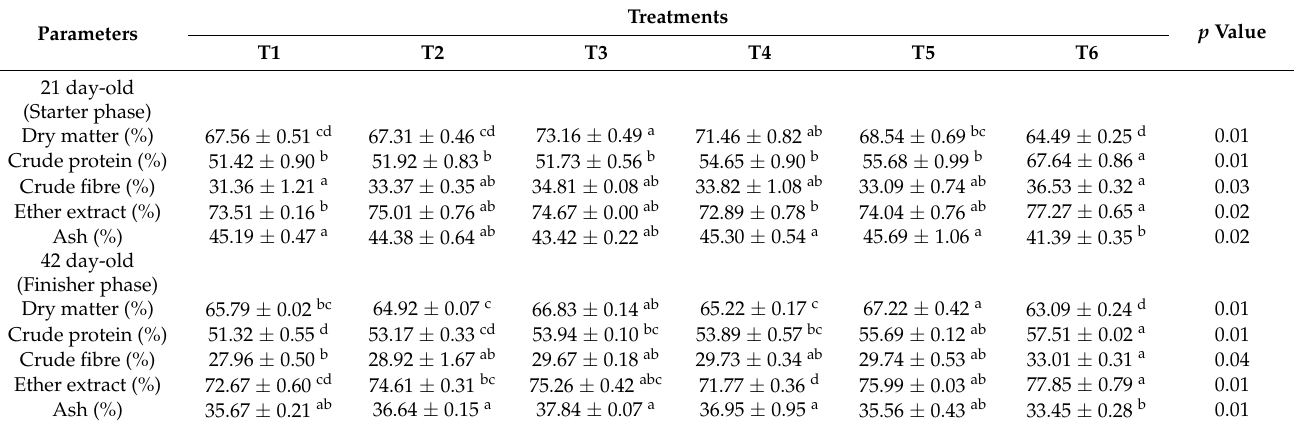
Table 3. Effect of Y. schidigera supplementation on the apparent ileal nutrient digestibility of broilers on day 21 and 42.